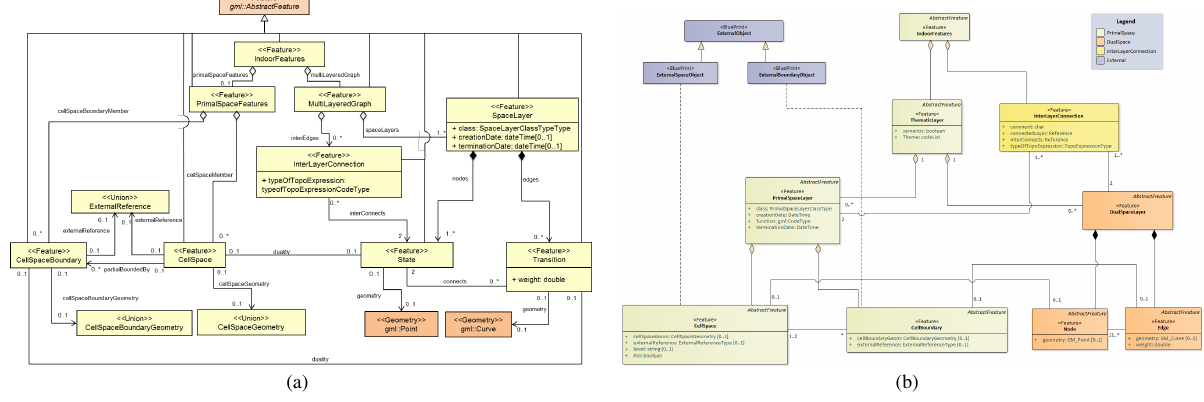
Figure 1. UML diagrams of the Core module of (a) IndoorGML 1.x and (b) IndoorGML